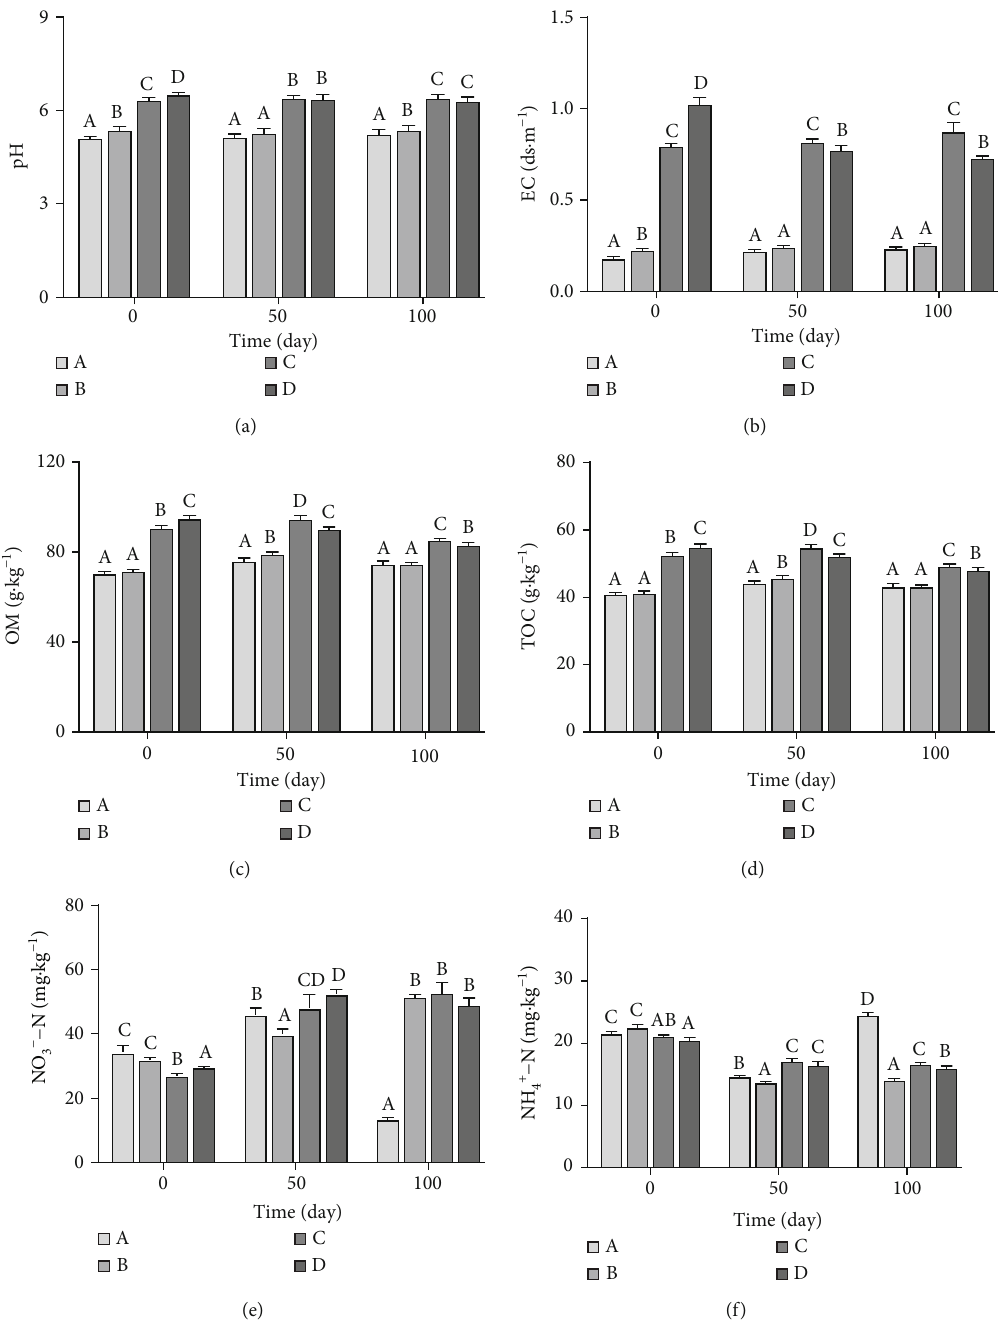
Figure 1: E ff ect of amendments on the soil properties: pH (a), EC (b), OM (c), TOC (d), NO 3- -N (e), and NH 4+ -N (f). Di ff erent letters above bars indicate signi fi cant di ff erences between mean values at each sampling occasion ( P <